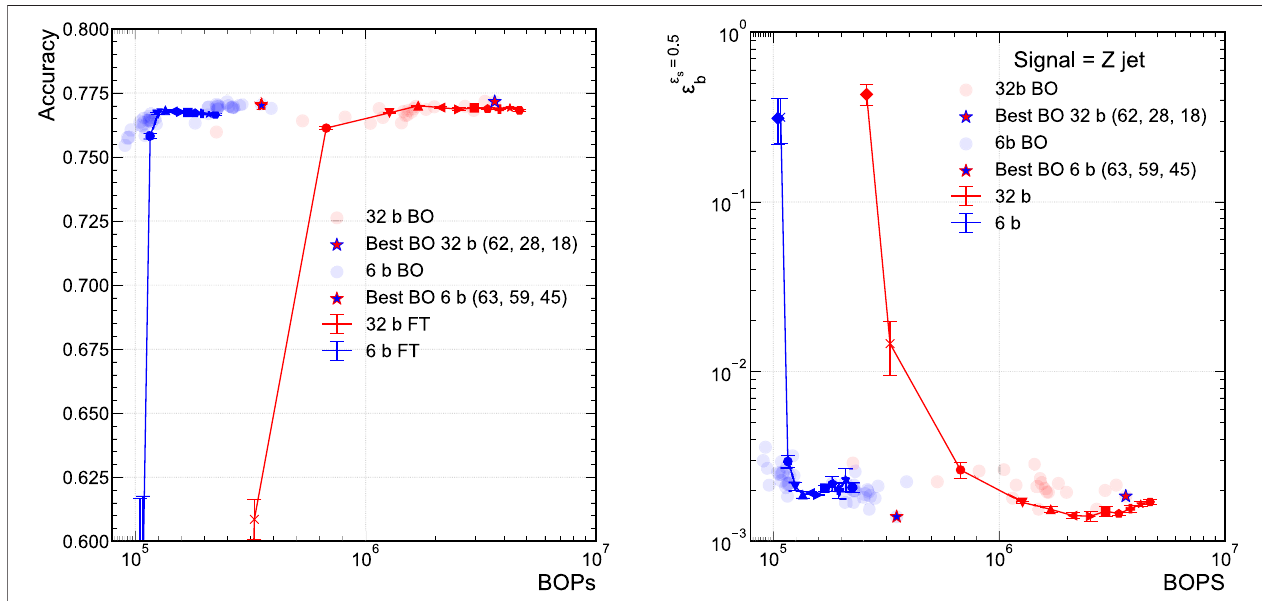
FIGURE 6 | Comparison of FT pruned model ’ s and BO model ’ s accuracy (A) and background ef fi ciency ( B ) at 50% signal ef fi ciency. Each hyperparameter con fi gurationthatwasexploredduringtheBOprocedureismarkedasatransparentdot,withtheresulting “ best ” model,whichthelowestBCELossascalculatedonthe “ test ” set, is marked by the outlined